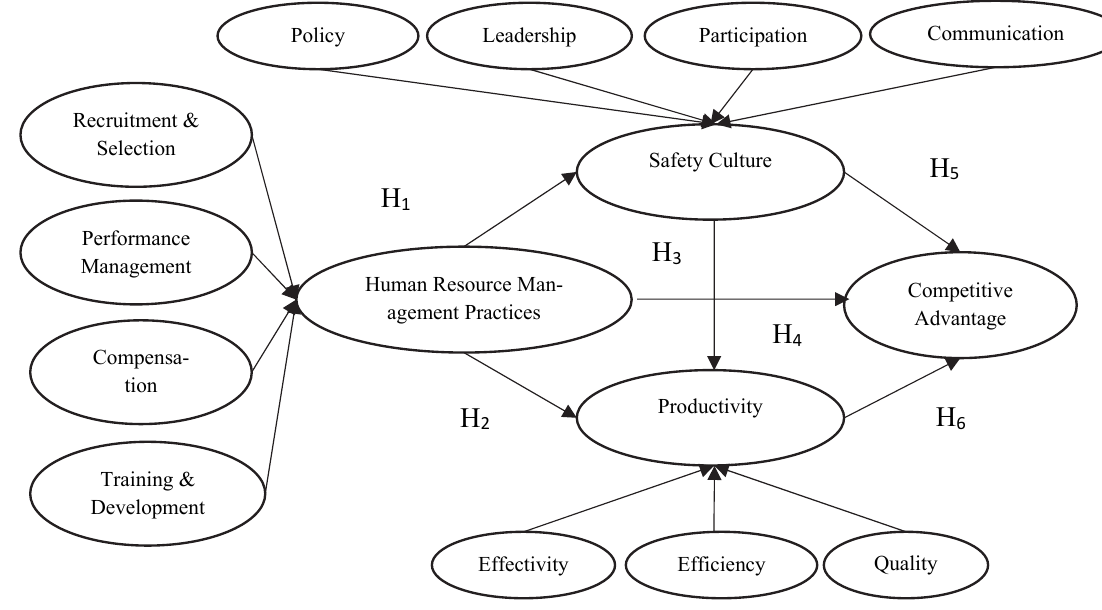
Fig. 3. The structure of the propsoed study